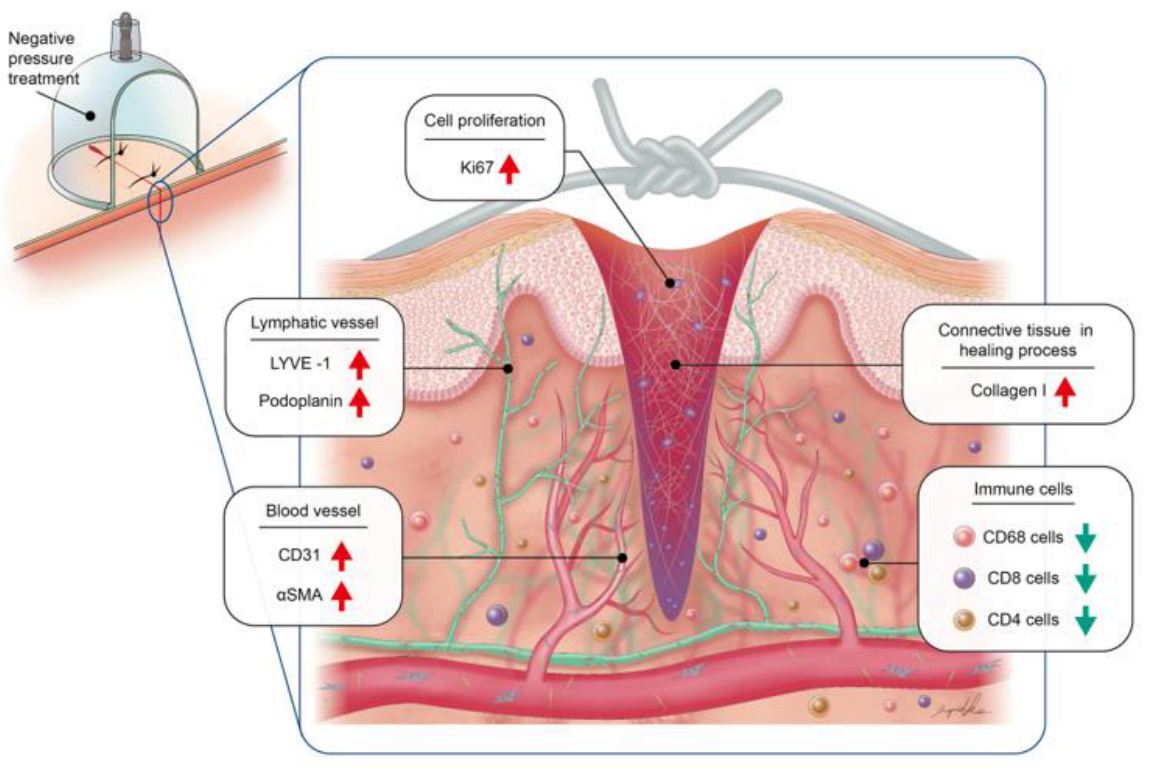
Figure 9. Schematic illustration of the effect of negative pressure on wound healing.